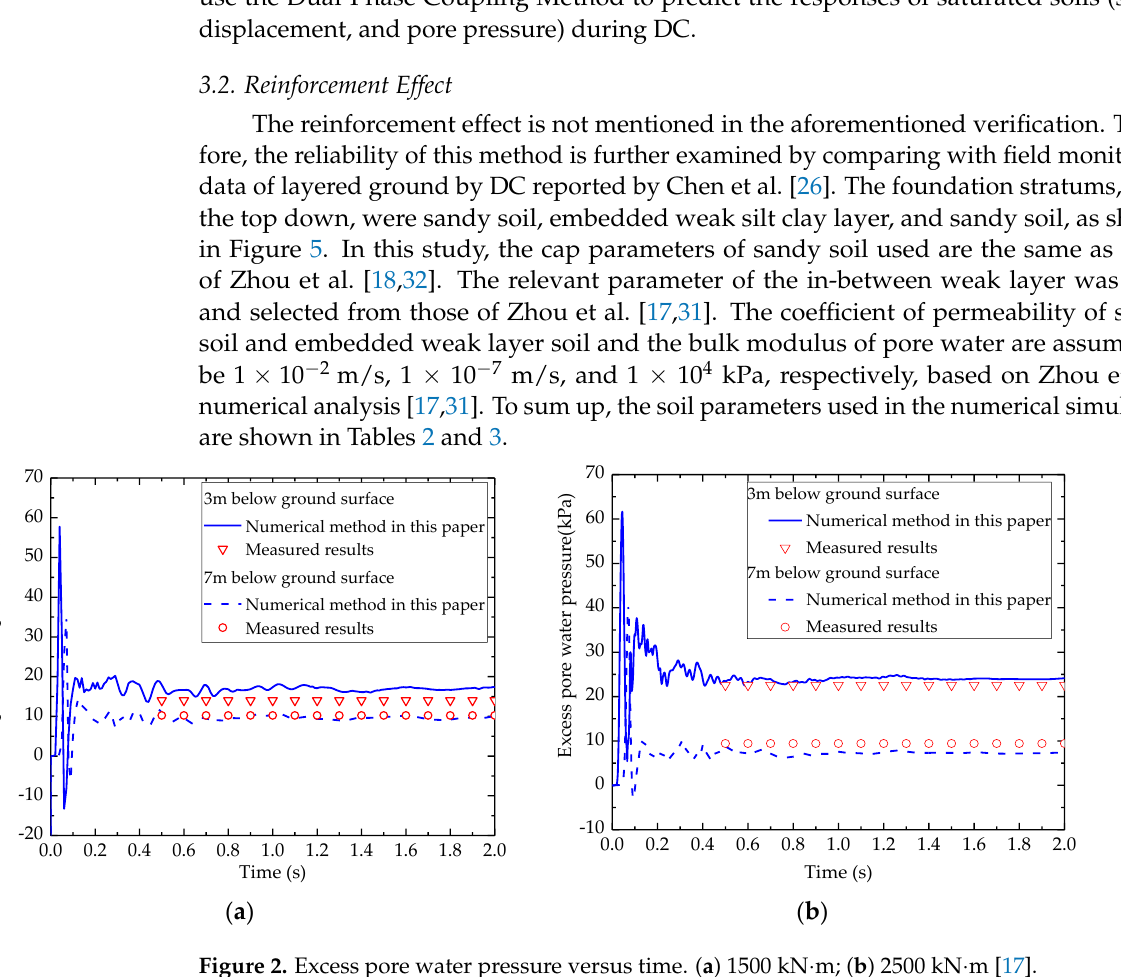
( b ) Figure 3. Comparison with the field results for the case of 1500 kN·m tamping energy. ( a ) Excess pore water pressure versus soil depth; ( b ) Lateral displacement versus soil depth. 0 2 4 6 8 10 12 14 16 18 20 22 24 26 28 30 -10-9-8-7-6-5-4-3-2-10 Excess pore water pressure(kPa) Measured results Numerical method in this paper D e p t h ( m ) -5 Measured results Numerical method in this paper Lateral displacement(mm) D e p t h ( m ) ( a )